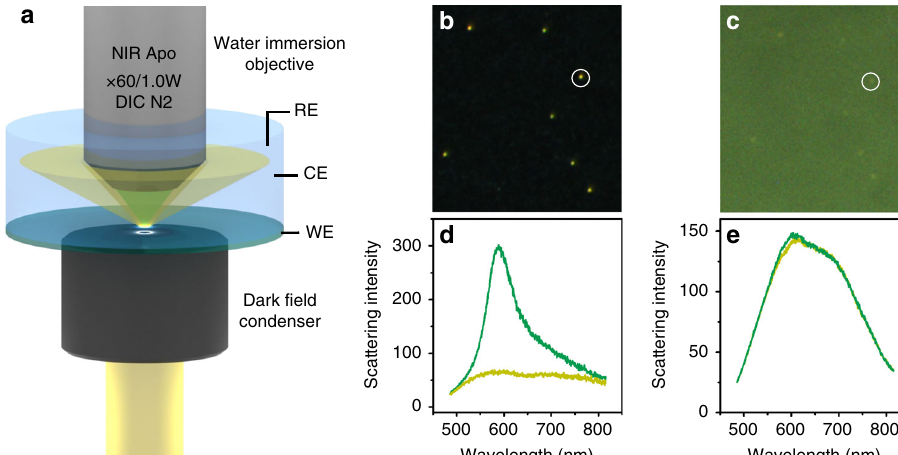
Fig. 1 A novel setup for the electrochemical dark fi eld scattering technique. a A schematic of the dark fi eld microscopy and spectroscopy on the basis of a water immersion objective (WE: working electrode, CE: counter electrode, RE: reference electrode). Dark fi eld image ( b ) and spectra ( d ) obtained on the new setup. Dark fi eld image ( c ) and spectra ( e ) obtained on the conventional setup. The exposure times for spectra in d and e are 1 and 10 s (normalized to 1 s),